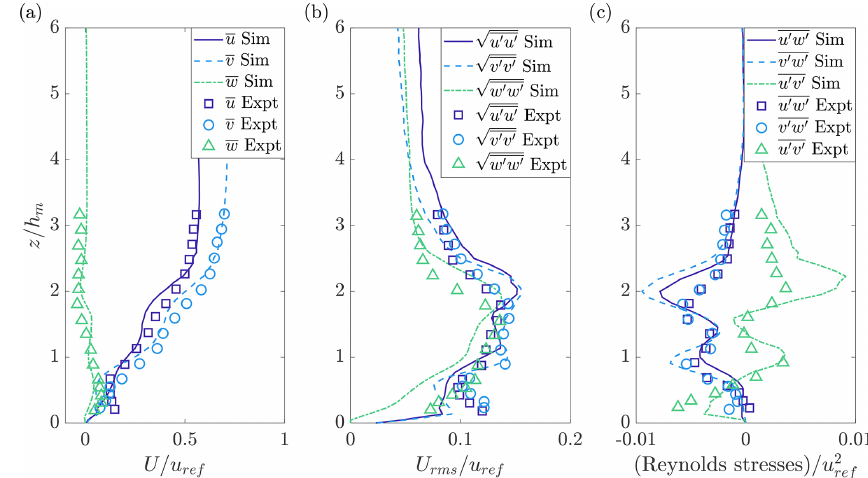
Figure 9. Vertical profiles of the (a) mean velocities, (b) root mean square velocities and (c) Reynolds stresses at position P 1 (see Fig. 7). Plotted against the wind tunnel experiment results of the DAPPLE